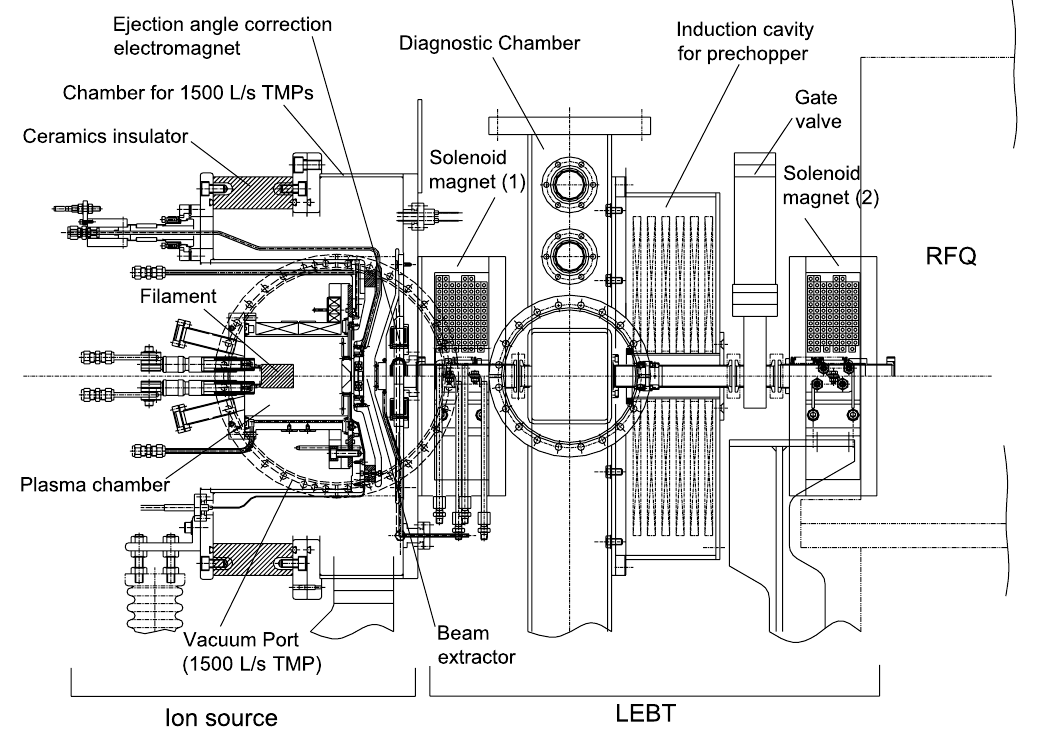
FIG. 2. Cross-sectional view of present J-PARC ion source and the